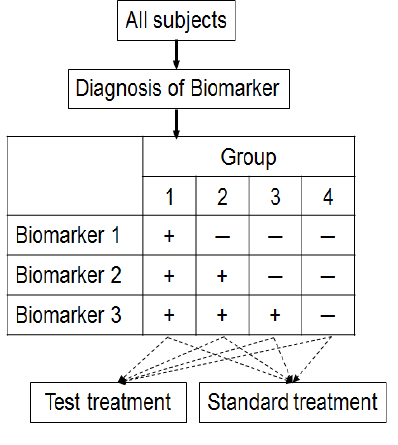
Figure 7. Framework for Bayesian adaptive design. Patients are assigned to biomarker groups 1–4 in sequential order according to the characteristics of the three biomarker categories. ‘+’ and ‘–’ correspond to the respective positive and negative biomarker statuses. Patients are adaptively randomized to one of the three treatments according to their biomarker groups. The dashed arrows indicate the putative effective treatment for each of the biomarker